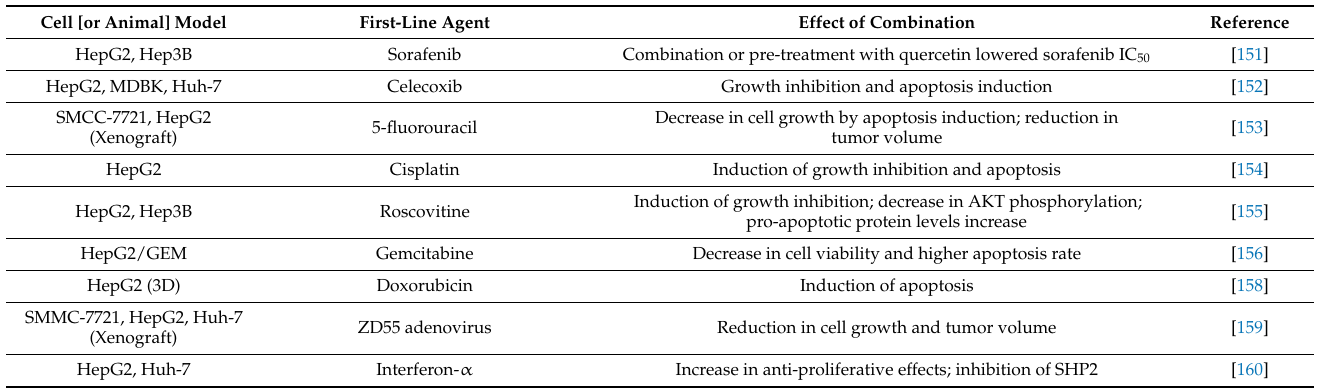
Table 8. Effects of co-administration of quercetin with first-line chemotherapeutic agents in HCC experimental